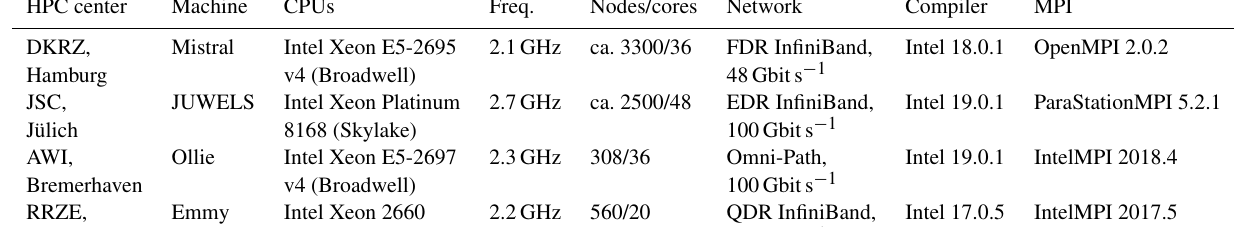
Table 2. Overview of the systems used in the scaling experiments.